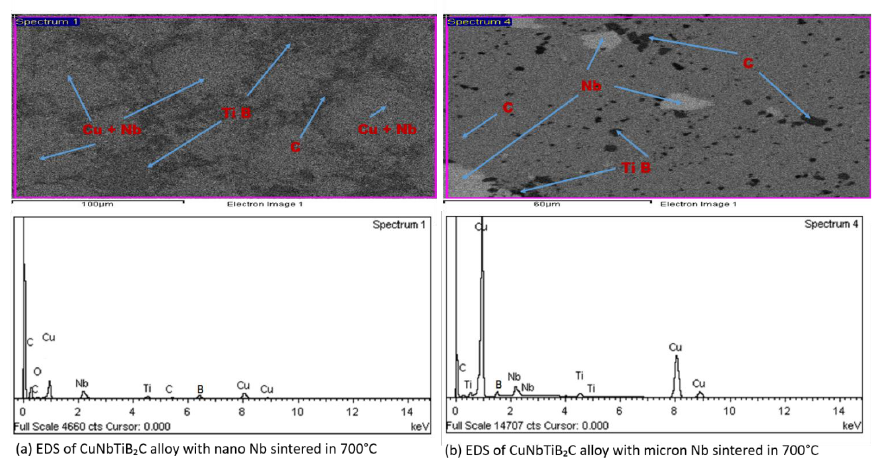
Figure 3. ( a , b ) compare the EDS graph of CuNbTiB 2 C alloys with nano and micron both sintered at 700 ◦ C.